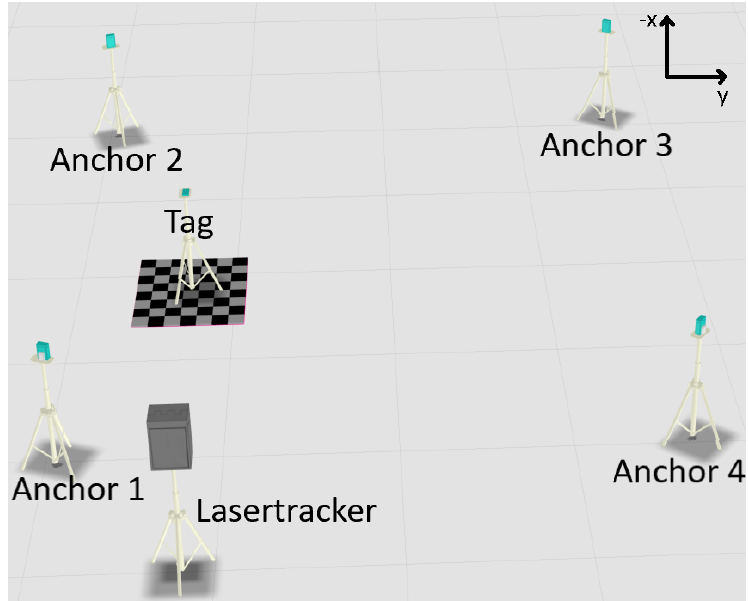
Figure 8. Visualization scenario 4: Four lines of sight in free